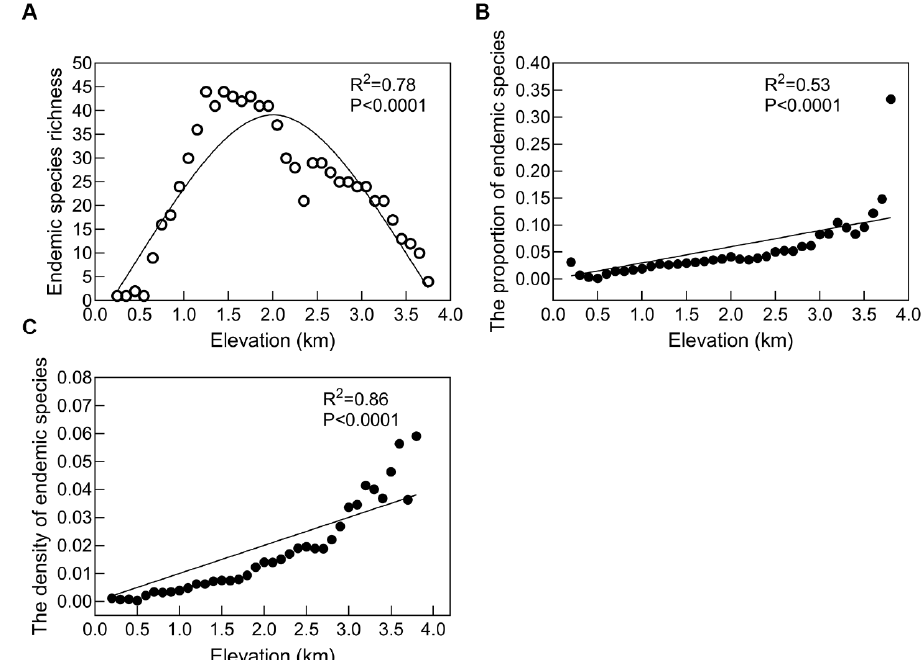
Figure 2. ( A ) The altitudinal patterns of endemic species richness in Qinling Mountains. ( B ) The proportion of endemic species along an altitudinal gradient. ( C ) The density of endemic species.